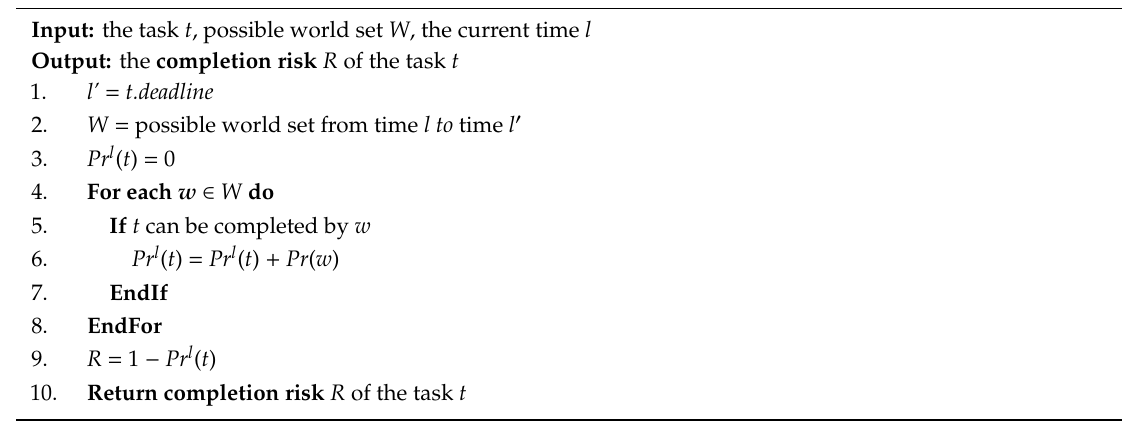
Algorithm 3. The Risk Prediction Model Risk( t , W , l )